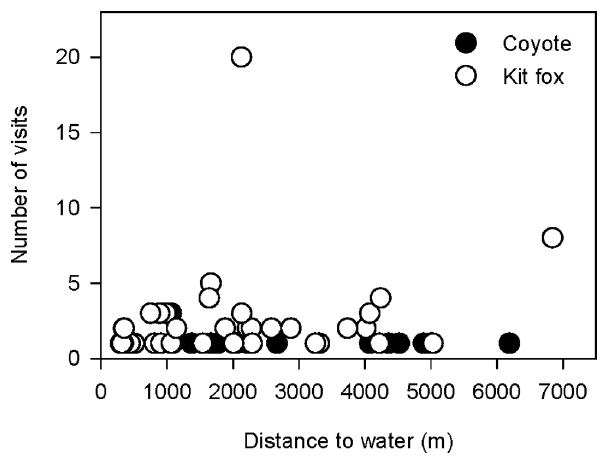
Figure 4. Visitation by canids to scent stations in relation to distance from free water. We defined a visit as all photo captures of a species occurring within 30 min. Data were collected on coyotes ( Canis latrans ) and kit foxes ( Vulpes macrotis ) in the Great Basin and Mojave Deserts, USA, 2011 to 2012.